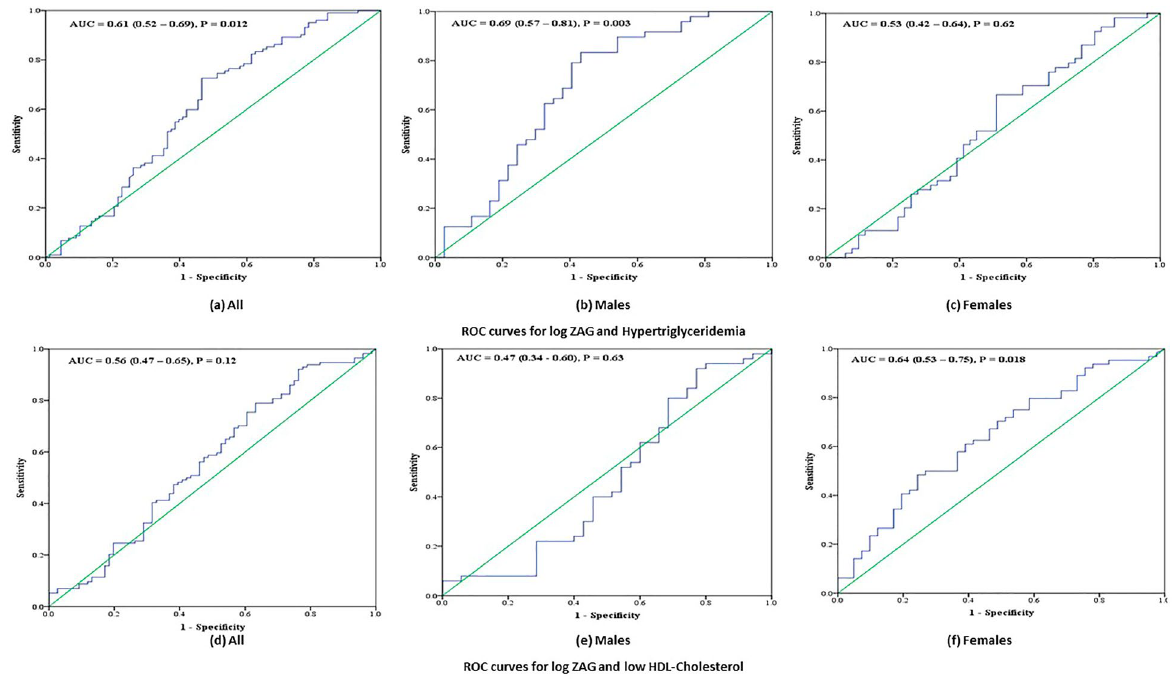
Figure 2. AUC for ZAG and MetS in a) All; b) Males; c) Females as well as AUC for ZAG and Hypertriglyceridemia in d) All; e) Males and f) Females.